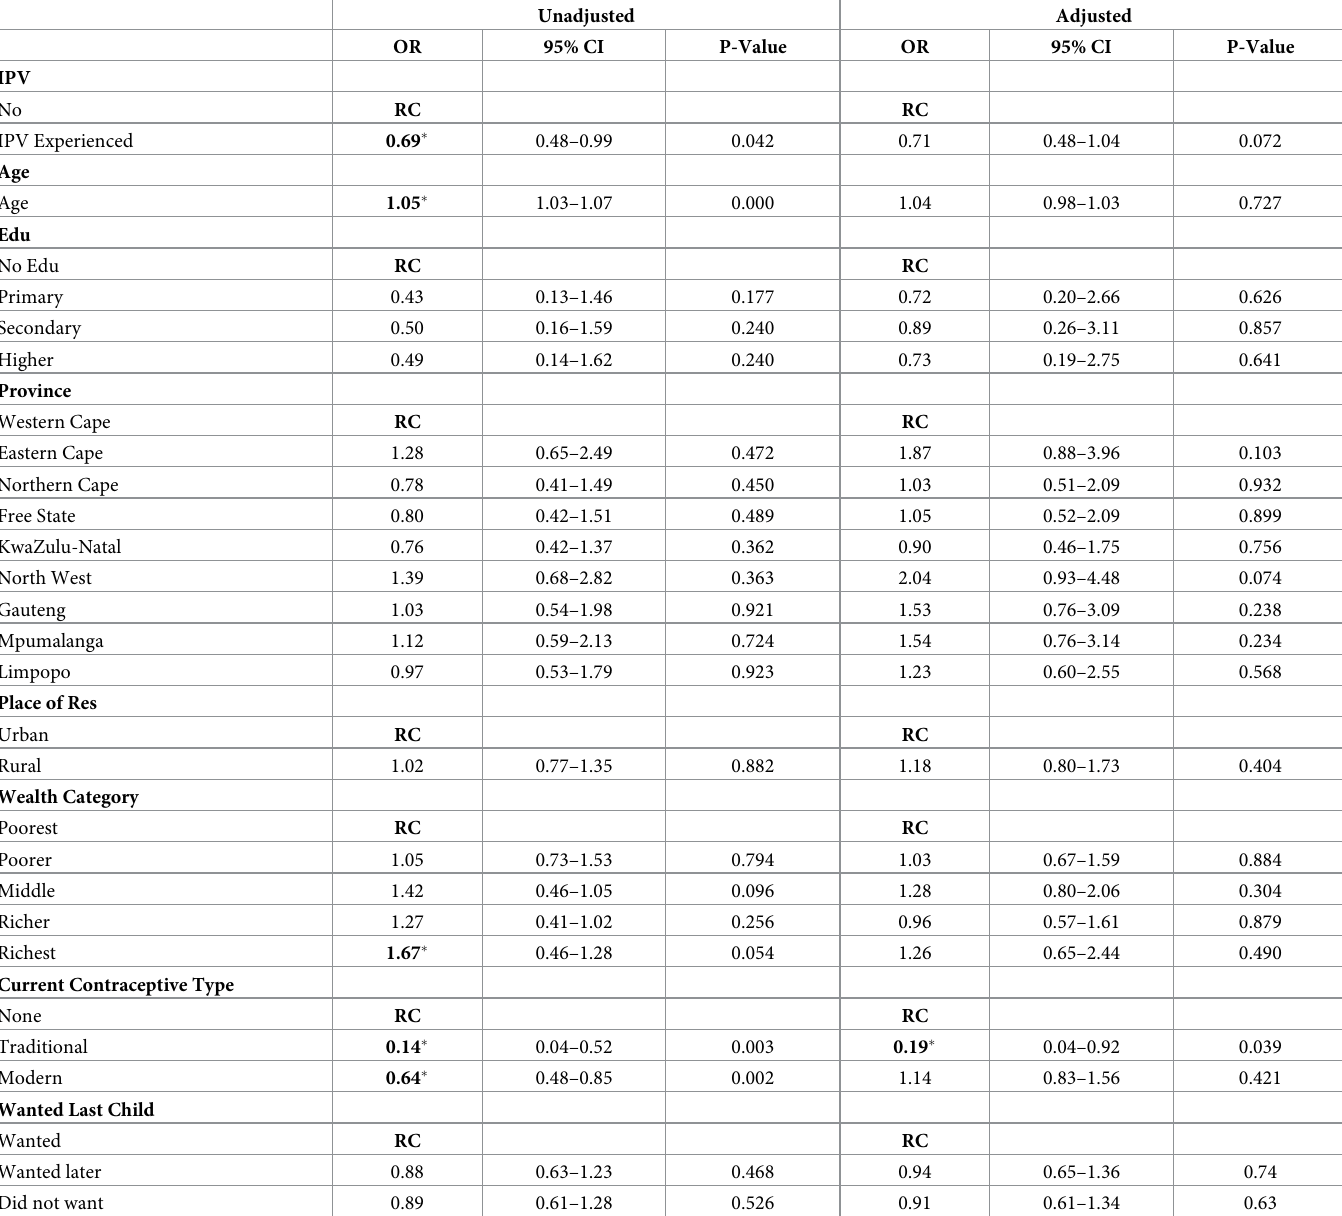
Table 4. Unadjusted and adjusted regression for low birth weight of last-born child. Unadjusted Adjusted OR 95% CI P-Value OR 95% CI